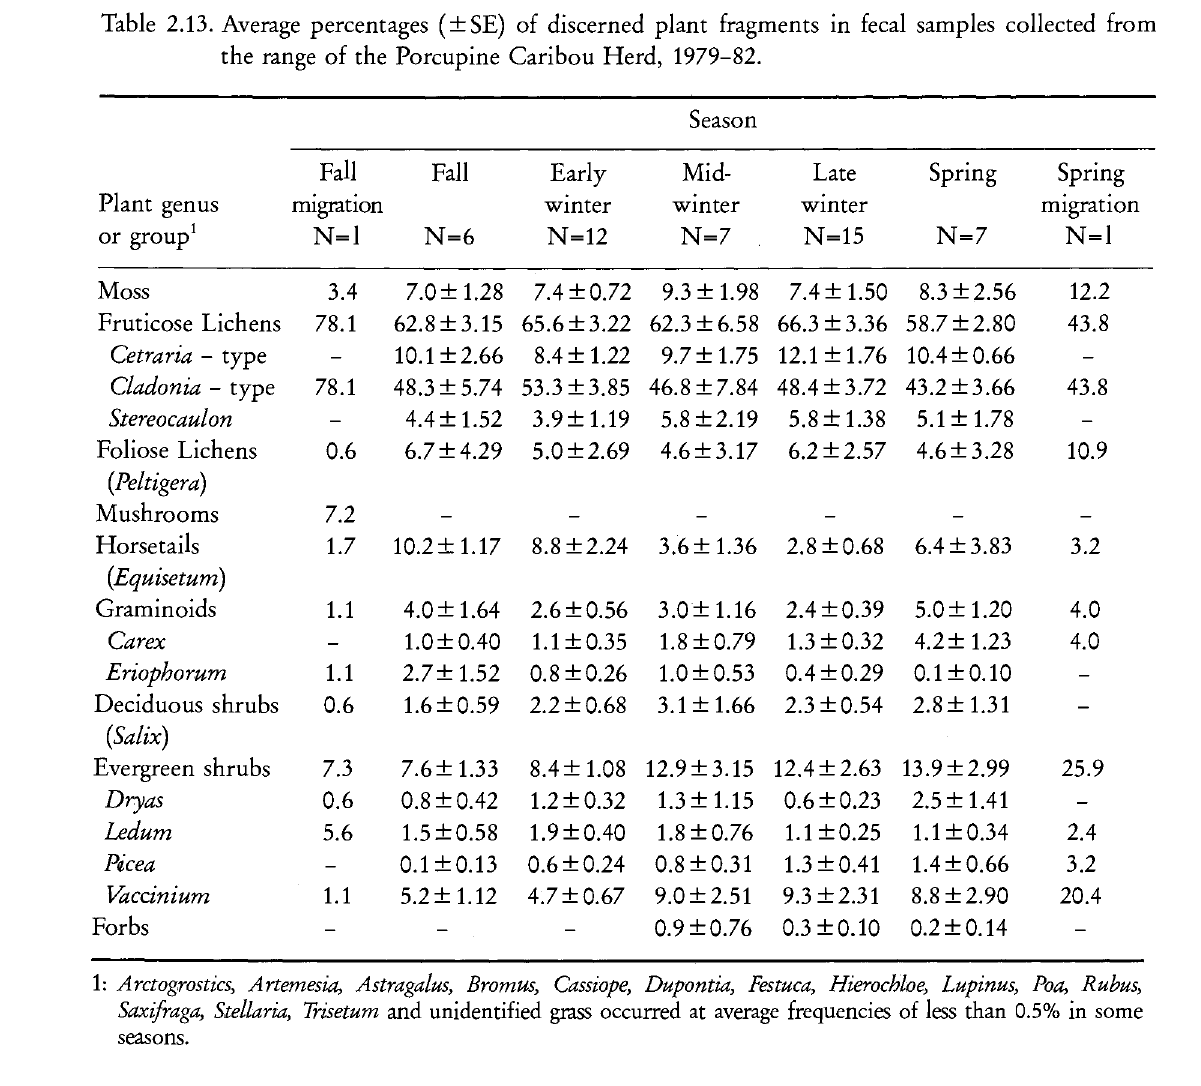
1: Arctogrostics, Artemesia, Astragalus, Bromus, Cassiope, Dupontia, Festuca, Hierochloe, Lupinus, Poa,